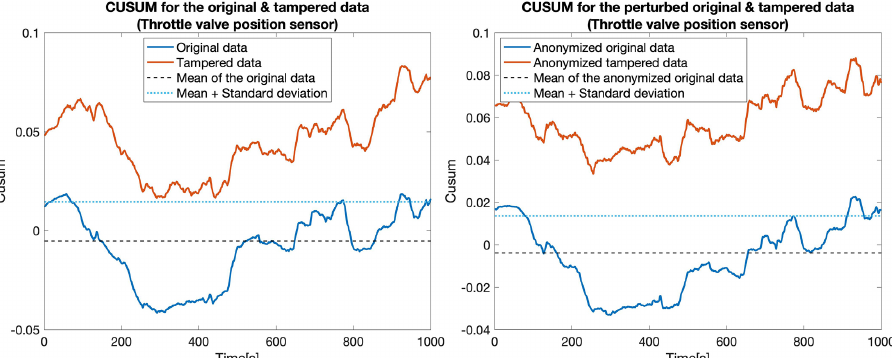
Figure 8. CUSUM for the original data (blue) and tampered data (orange) for the Throttle valve position sensor.